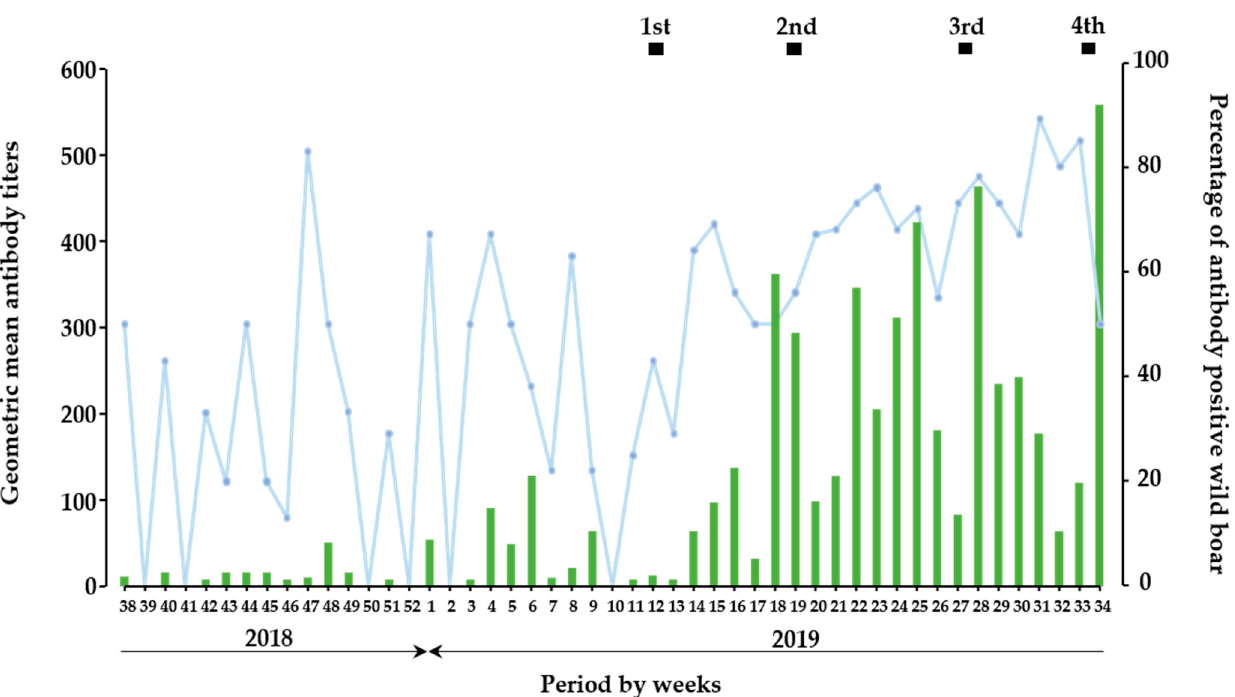
Figure 1. Prevalence of antibodies against CSFV in wild boar. In temporal trend analysis, results on wild boar samples (n = 1166) were combined and analyzed as a week base. The green bar indicates the GMT of SNT in wild boar sera per week, and the blue line indicates the percentage of antibody-positive wild boars in each week. The black box indicates the duration of oral vaccination.